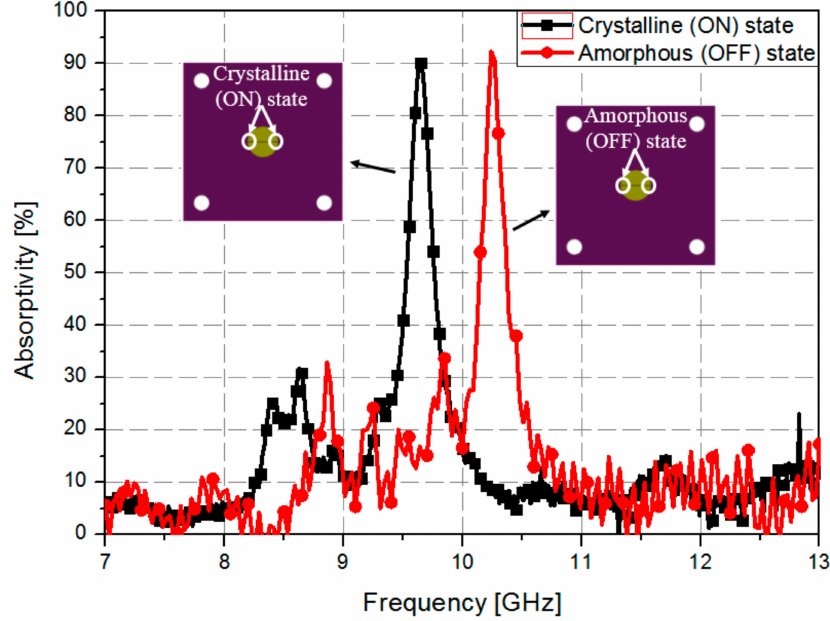
Figure 9. Measured absorptivity versus a frequency at different states of the